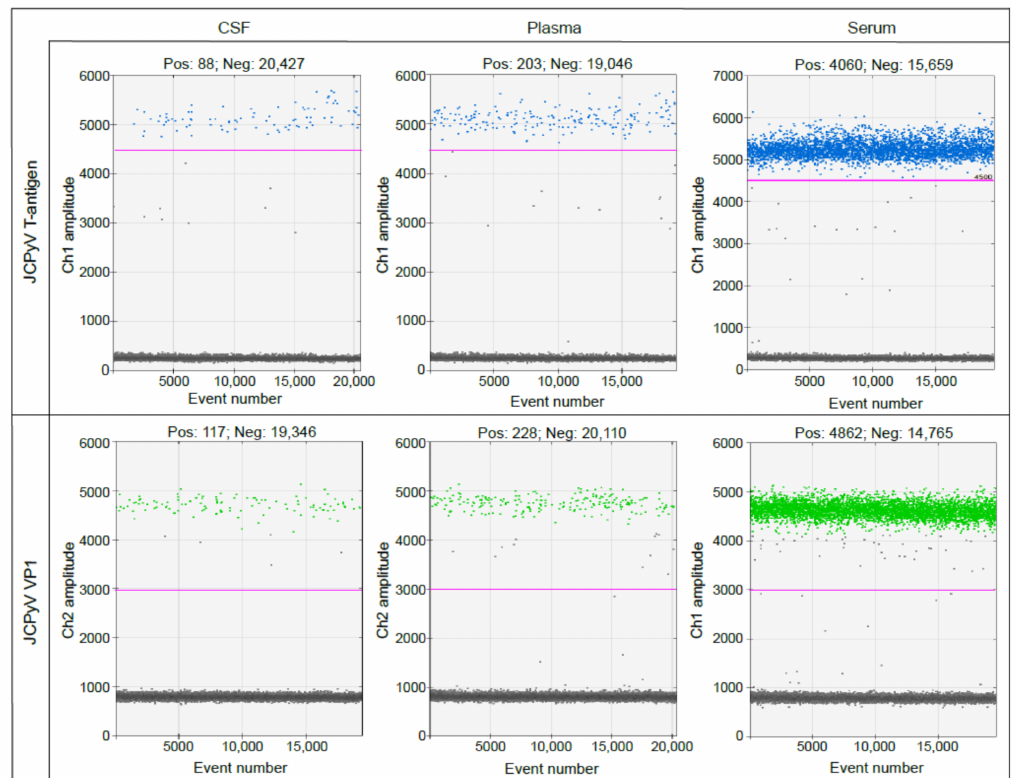
Figure 7. Examples of droplet count and thresholding used in the analysis. Controls were generated for each biofluid (plasma, serum, and CSF) by spiking 250 µ L healthy donor fluid with 5 µ L JCPyV-positive EV. EV were isolated using size-exclusion chromatography mini-columns (Izon, Christchurch, New Zealand) followed by ultrafiltration using Amicon Ultra-4 columns (Merck-Millipore, Burlington, MA, USA). Purified and concentrated EV were processed according to the workflow diagram and analyzed by ddPCR for JCPyV T-antigen and VP1 expression. The amplitude of each positive control was used to determine the threshold setting, shown as a pink line, for each probe